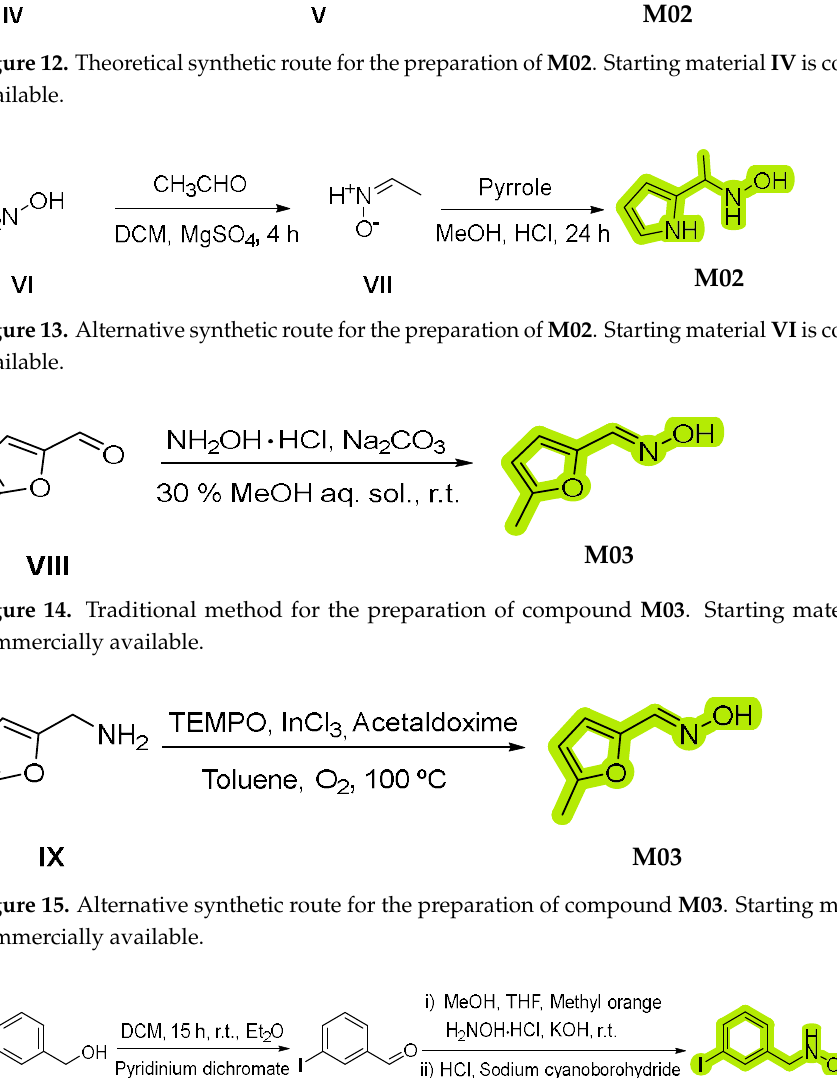
Figure 16. Synthetic route for the preparation of MO4 . THF (tetrahydrofuran), Potassium hydrox- ide, Starting material X is commercially available.